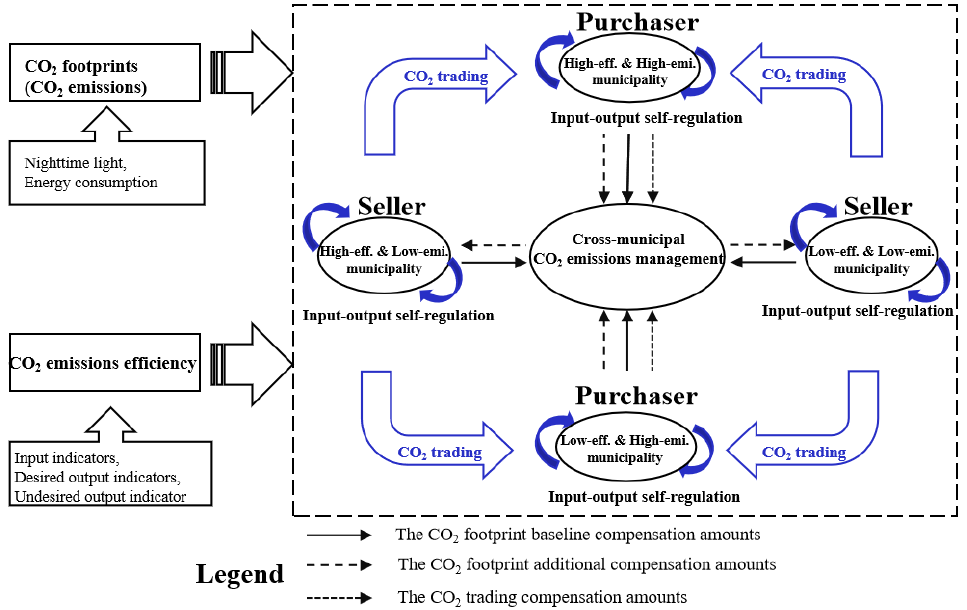
Figure 1. Diagram of the horizontal CO 2 compensation mechanism in the YRD. Note: eff. and emi. are abbreviations for efficiency and emissions,